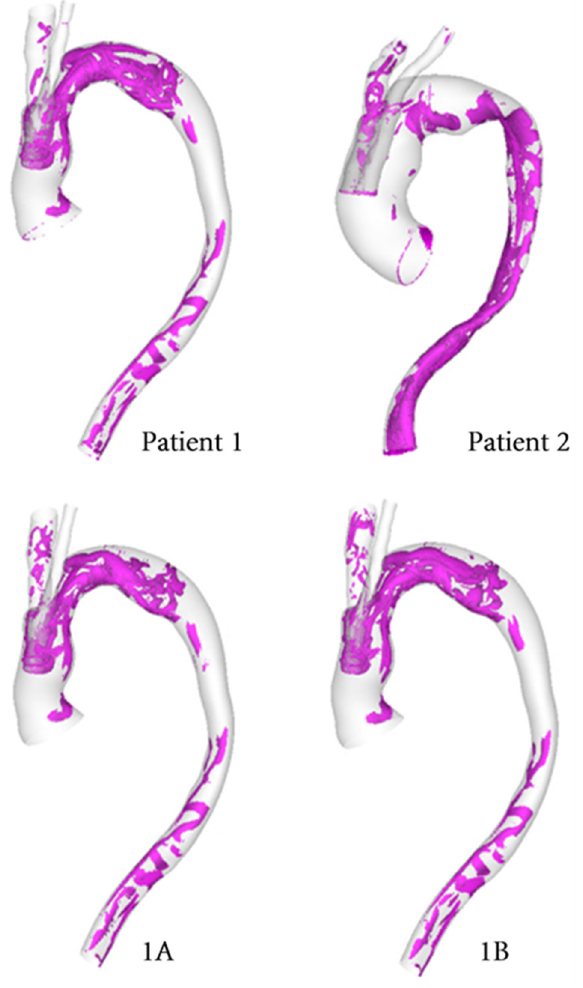
Figure 11. Isosurfaces used to depict vortical structures isolated using the λ 2 criterion computed for